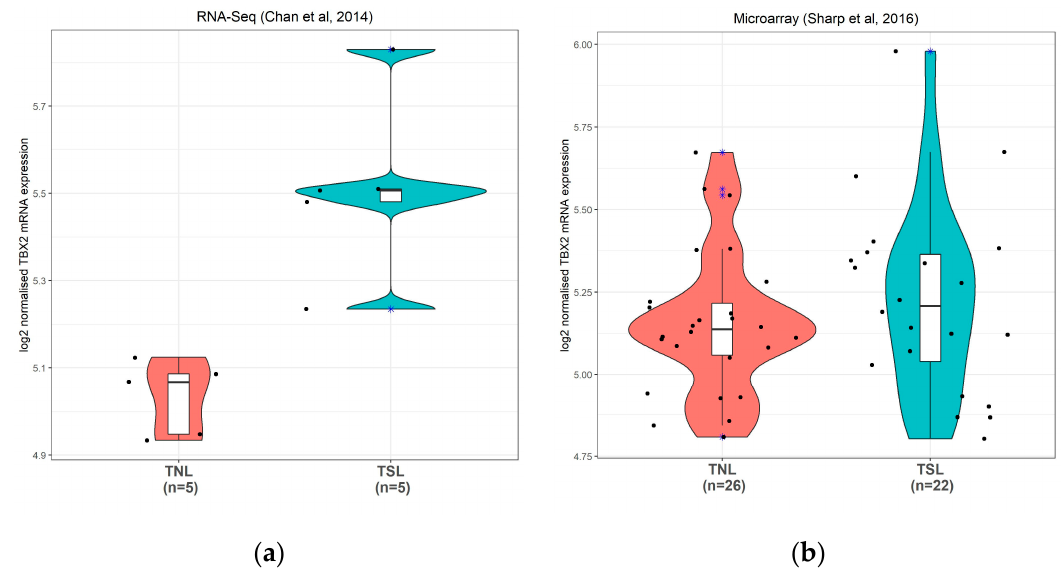
Figure 5. TBX2 mRNA expression in human preterm myometrial samples. ( a ): TBX2 expression in human myometrium by RNA-Sequencing (extracted from Chan et al., 2014). ( b ): TBX2 expression in human myometrium by microarray profiling (extracted from Sharp et al., 2016). A blue asterisk marks outliers. Dots indicate individual data points. The width of the density curves in the violin plot corresponds to the frequency of the observations. The box & whisker plot in the center with a median represents the interquartile range and the 95% confidence intervals. TNL: Term no labour; TSL: Term spontaneous labour. * t -test p value < 0.05.